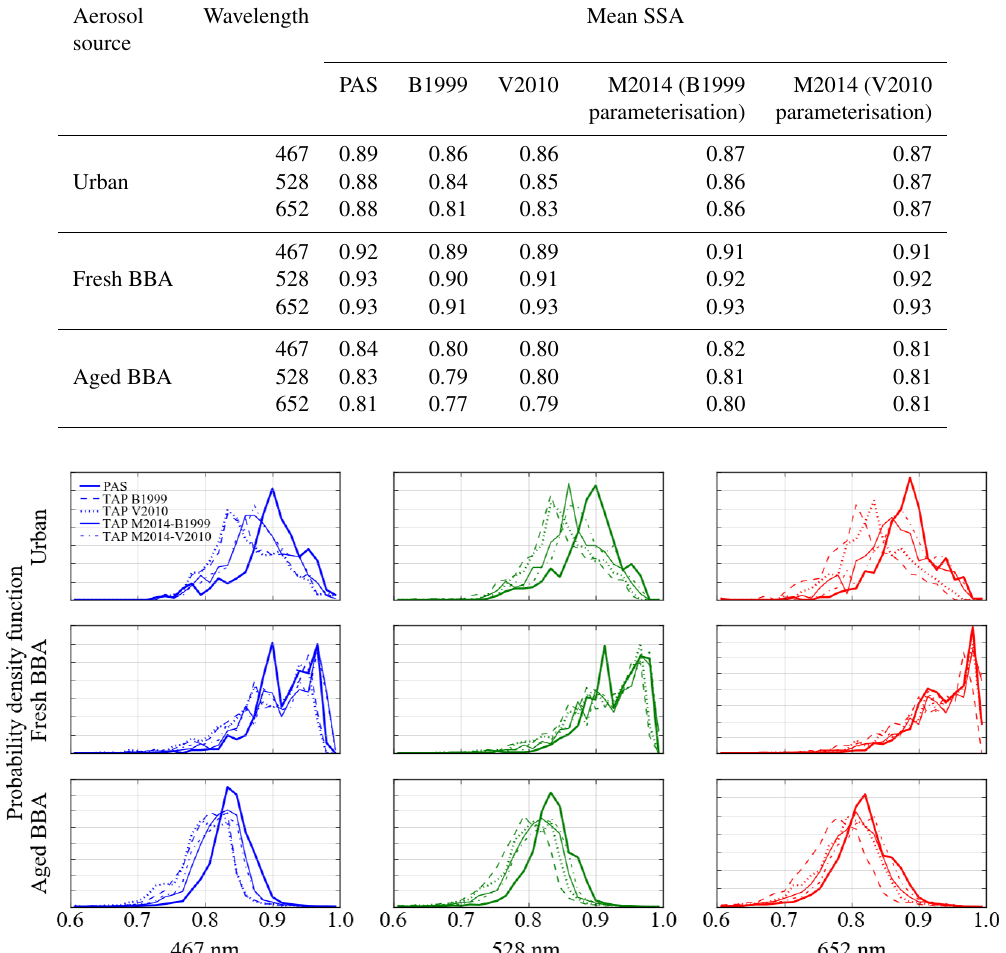
Table 3. Campaign-mean single-scattering albedo (SSA) derived using PAS and CRDS measurements and TAP and CRDS measurements.